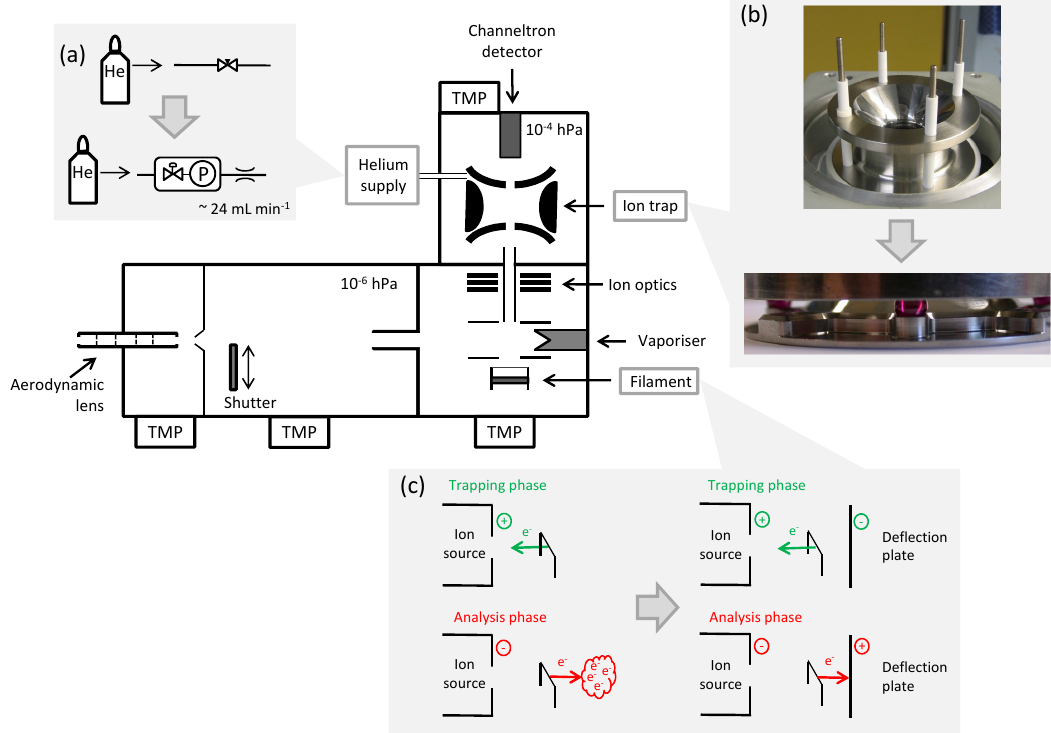
Figure 1. Schematics of the IT-AMS. The insets (a) – (c) visualise the major hardware modifications (compared to Kürten et al., 2007) described in the main text. (TMP: turbo molecular pump; photographs from Fachinger,